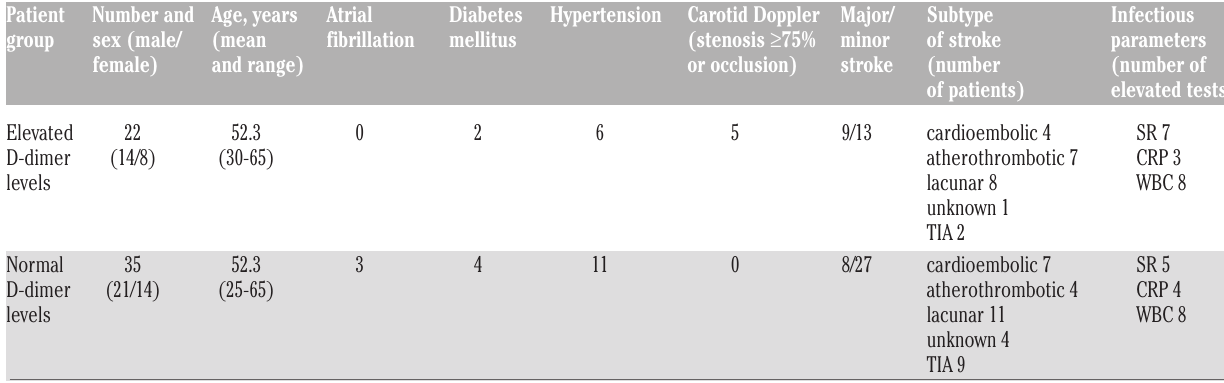
Table 1. Characteristics of patients with elevated and normal D-dimer levels.